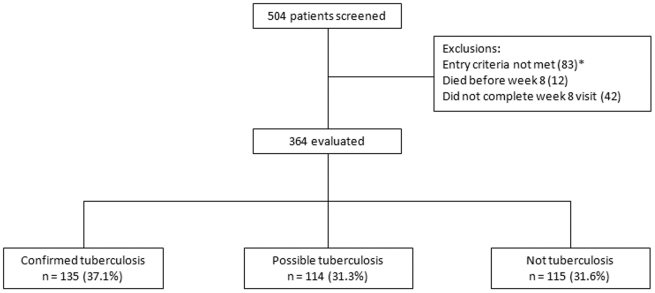
Participant flow chart and final diagnosis.* Reasons for exclusion (n) Not able to attend for regular review - determined during screening visit (28) No active symptoms (17) Alternative medical diagnosis made at screening (14) Karnofsky Score <40 (5) Pneumocystis pneumonia (4) Informed consent not obtained (3) Sputum smear positive (3) Already on antitubercular therapy (3) Other (6).